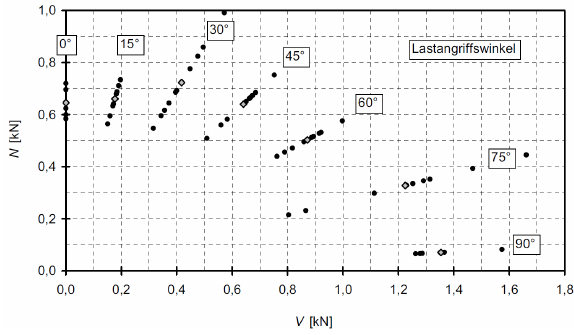
Figure 8. Load capacity depending on the relation between axial / lateral load, (DAfStb